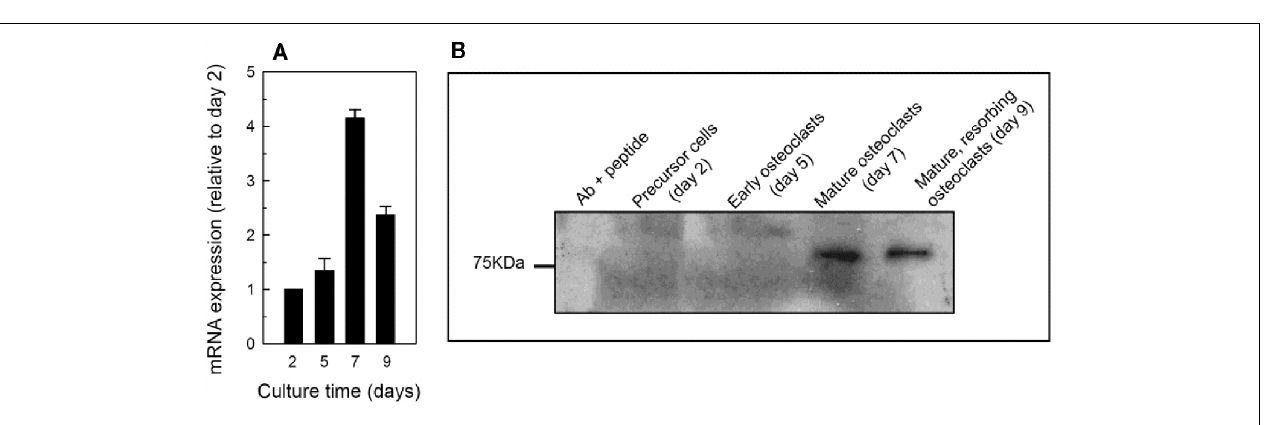
non-activated cells (day 7). (B) P2X7 receptor protein was not detected in precursor cells or early osteoclasts but was present in mature cells. Unlike the mRNA, no differences in protein level were detected between mature and mature, resorbing